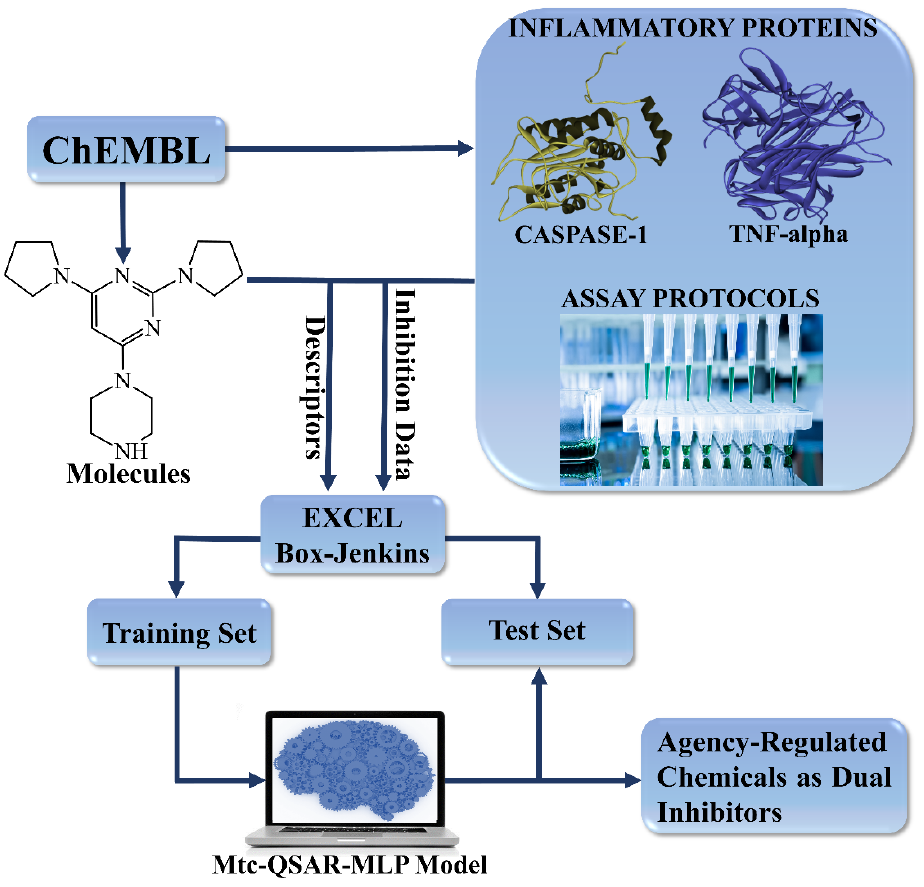
Figure 1. Development and application of an mtc-QSAR-MLP model.